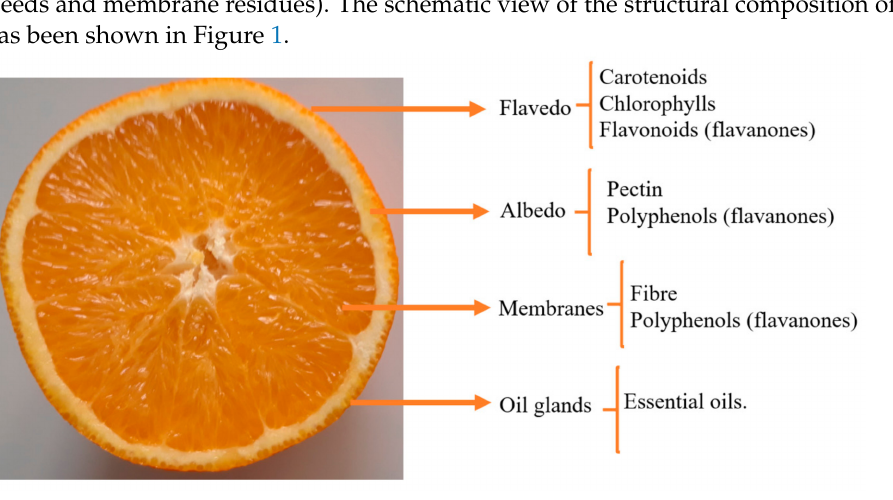
Figure 1. Schematic view of structural composition of